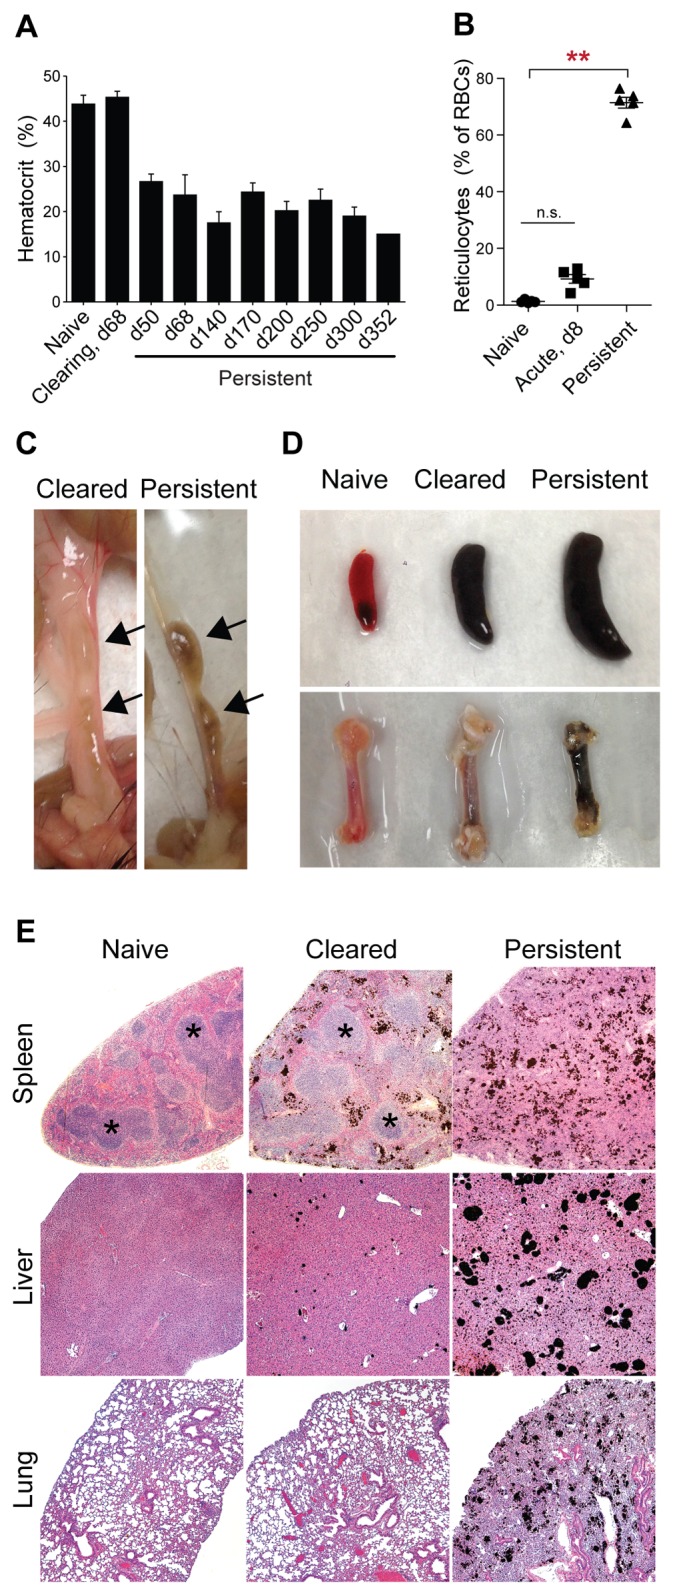
Blood and tissue pathology in persistently infected mice.(A) Hematocrit (mean + SEM) was measured on the indicated days (d) post infection (n = 3–5 mice per group, except n = 1 on day 352). Clearing, Ifngr1-/- mice infected and treated with control antibody as in Fig 1B. Persistent, Ifngr1-/- mice infected and treated with α-CD4 antibody as in Fig 1B. (B) Reticulocytes were enumerated as a percentage of total erythrocytes. 8 d.p.i., Ifngr1-/- mice infected with P. chabaudi for 8 d. Each dot represents one mouse; means + SEM are shown. **, p < 0.01 by Kruskal-Wallis test with Dunn's post-test. n.s., not significant. (C) Mesenteric lymph nodes (arrows) in cleared and persistently infected mice, 331 d.p.i. (D) Spleens (top) and femurs (bottom) from representative mice, 331 d.p.i. (E) Tissues were excised from the indicated mice 331 d.p.i., processed, and stained with hemotoxylin and eosin. Asterisks mark representative B cell follicles in naive and cleared spleen sections.